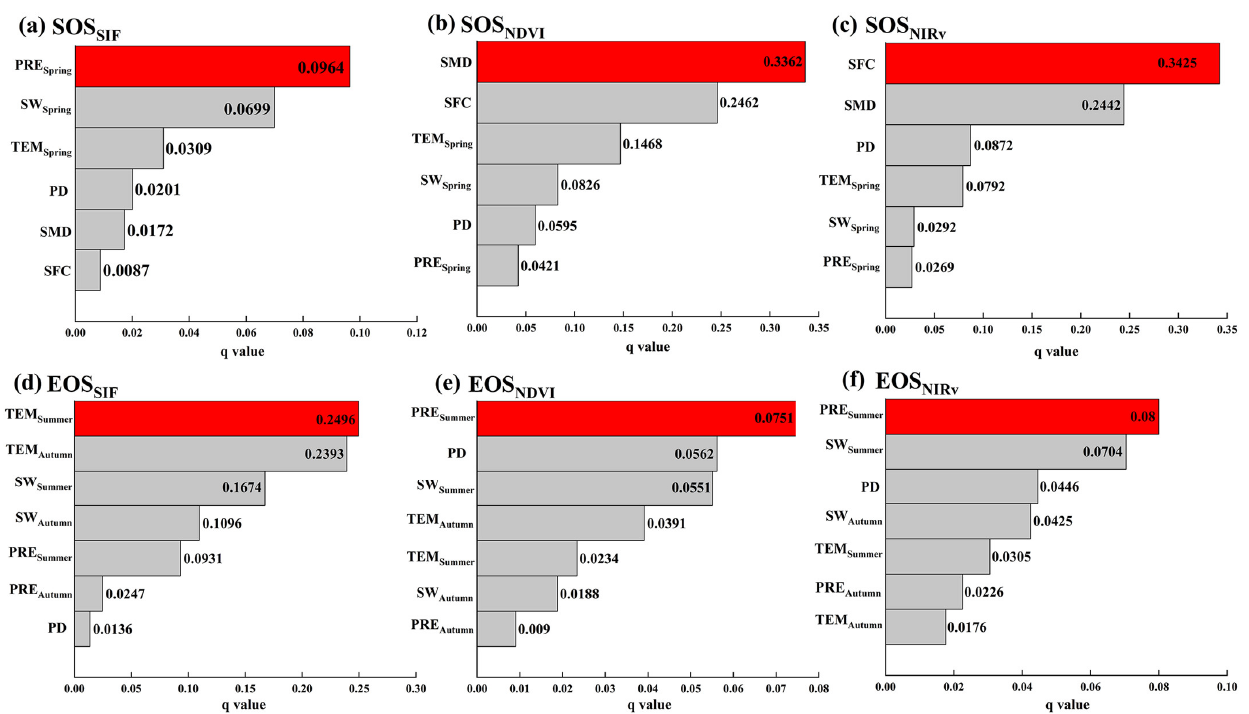
Figure 13. Interpretations of various influencing factors on SOS and EOS: ( a – c ) are SOS SIF , SOS NDVI and SOS NIRv, respectively; ( d – f ) are EOS SIF , EOS NDVI and EOS NIRv ,